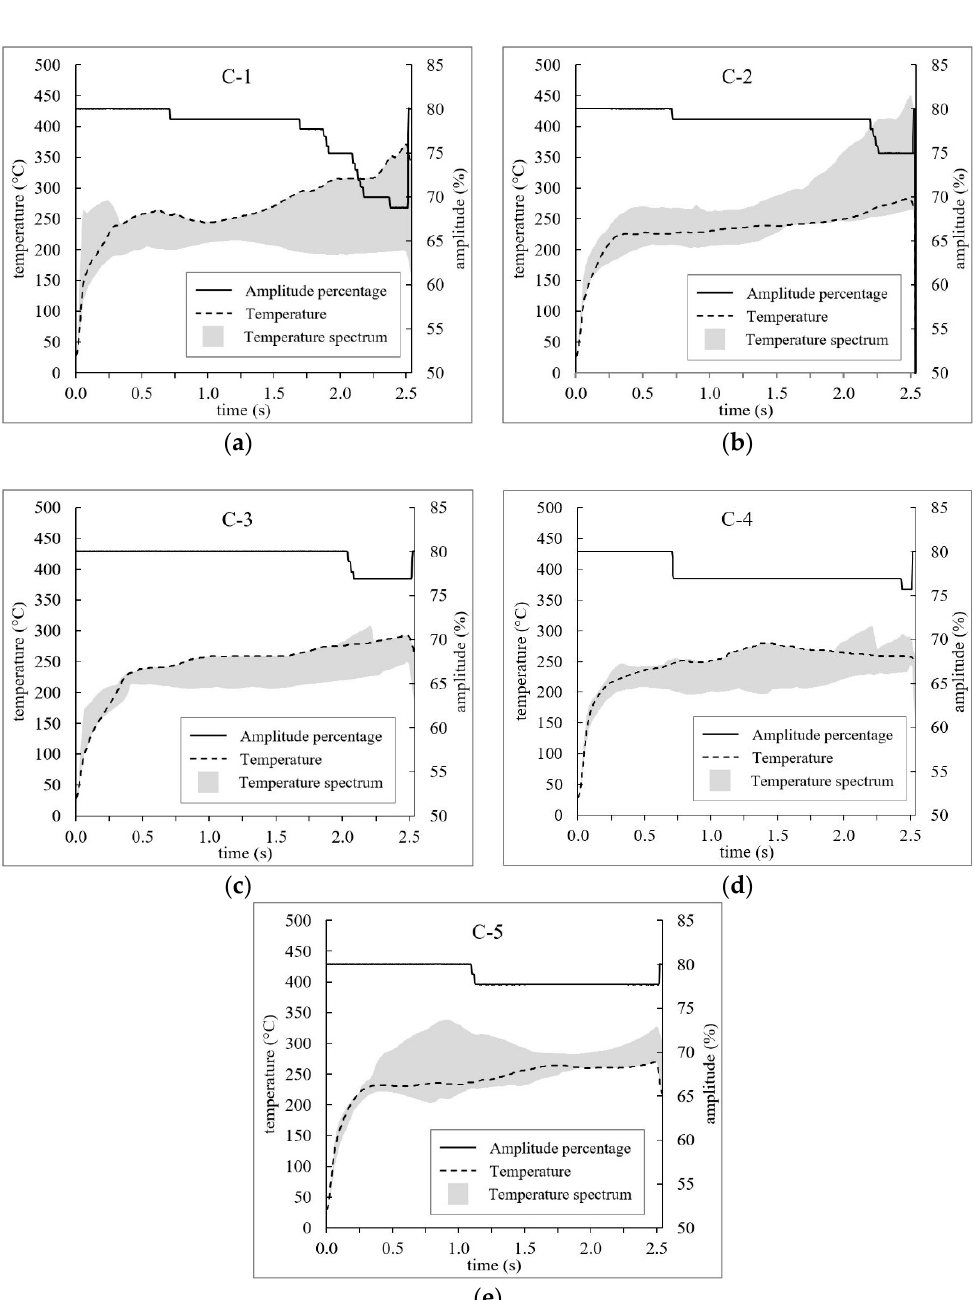
Figure 10. The time traces of the temperatures measured in the center of the weld spot (dotted lines) and the corresponding adjusted amplitude for the controlled weld cases and the shaded areas represent the temperature spectrum from the repetitions. The results of the each control parameter case are plotted in ( a ) C-1, ( b ) C-2, ( c ) C-3, ( d ) C-4, ( e )